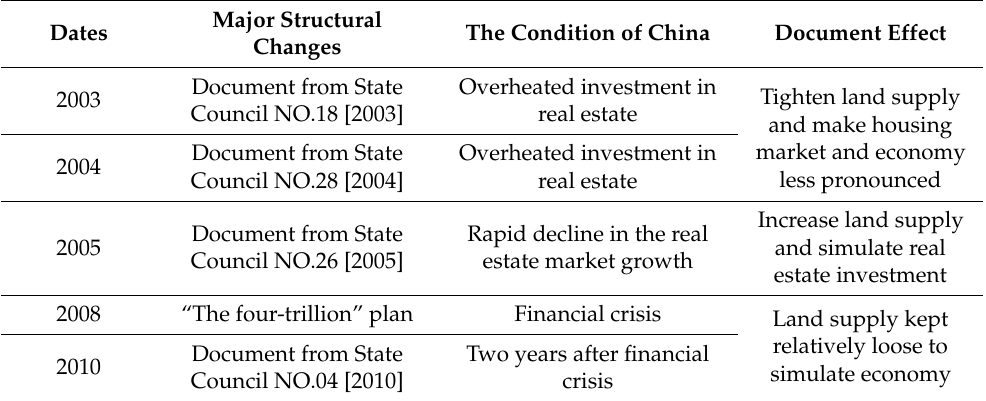
Table 7. Chronology of structural